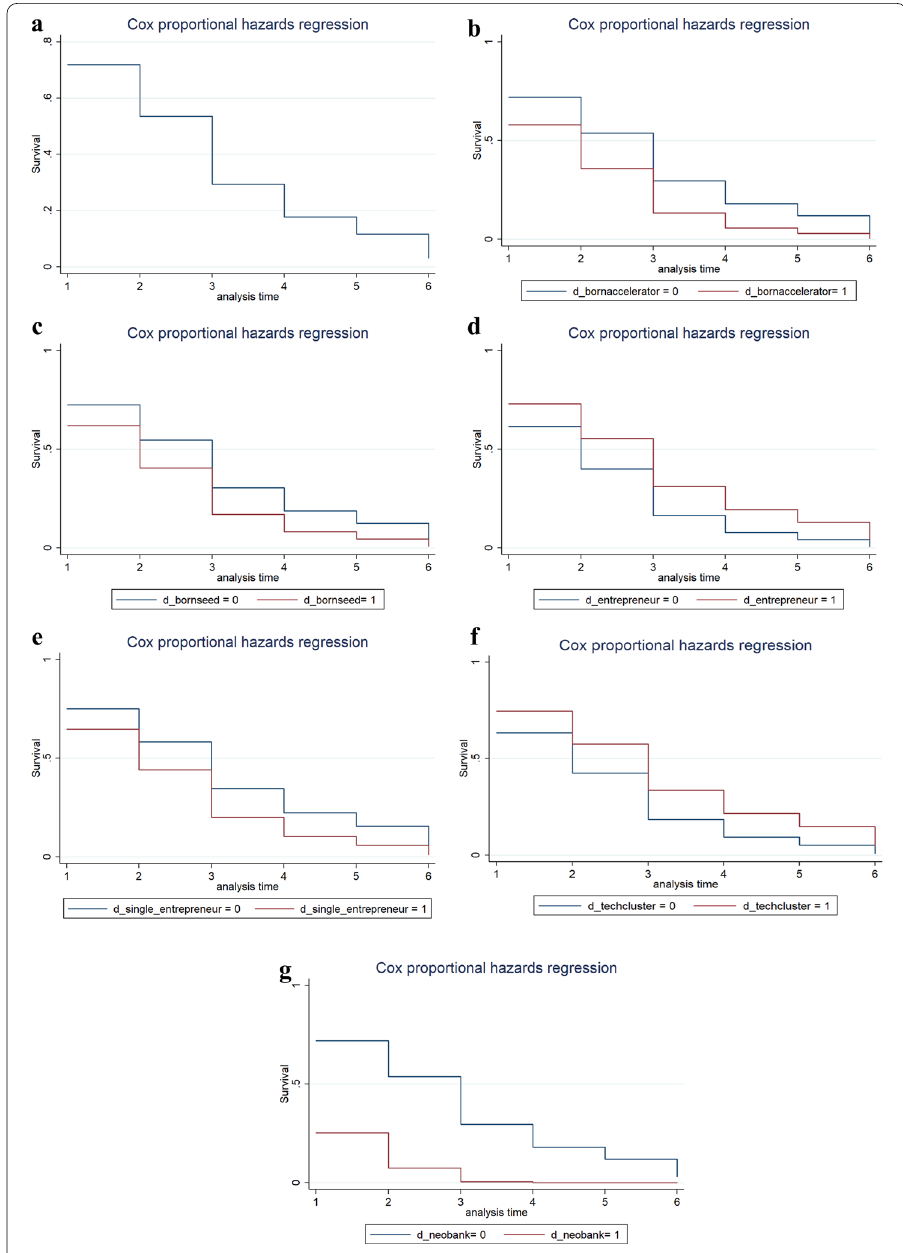
Fig. 1 Cox proportional hazards regressions. Survival Functions. These figures plot the survival functions for the Cox proportional hazards regressions. a Plots the survival functions for the entire model. b Plots the survival functions whether the FinTech company was created as part of an accelerator or incubator program or not. c Plots the survival functions whether the FinTech company raised funds through seed capital at an early stage or not. d Plots the survival functions whether the FinTech company was founded by an entrepreneur/s or not. e Plots the survival functions whether the FinTech company was is founded by a single entrepreneur. f Plots the survival functions by the location of the FinTech company. g Plots the survival functions whether the FinTech company is a neobank or